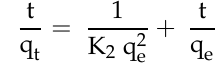
+ ion removal percentages + + ) and 0.045 g (for Cr 6 )